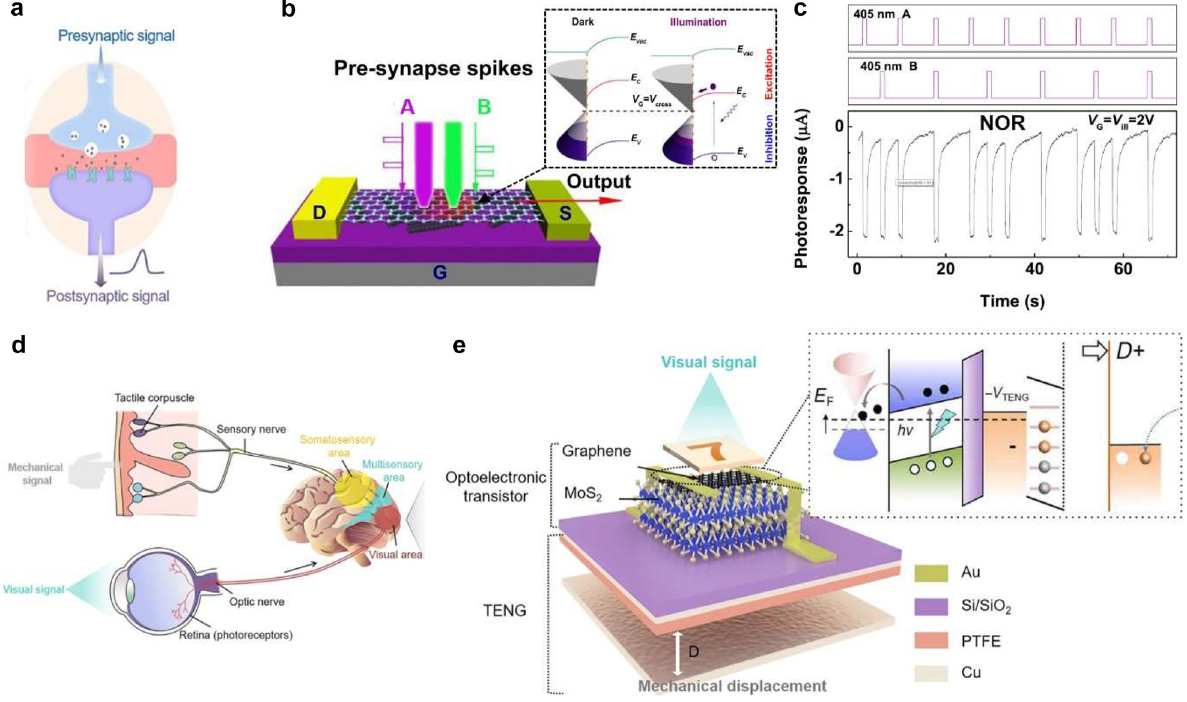
Figure 9: Data processing applications of graphene. (a) Schematic of biological synaptic transmission. (b) Artificial axon-multi-synaptic network based on graphene-SWCNTs hybrids under multiple light spikes. Inset image is the band diagram of graphene/SWCNTs interface before and after illumination. (c) The dynamic photoresponse of the NOR logic operation of the network. (d) Schematic illustrations of biological tactile/visual sensory systems. (e) Schematic structure of a graphene/ MoS 2 heterostructure-based arti fi cial synapse. The inset is the band diagram of the graphene/MoS 2 mechano-optoelectronic transistor at sepa- ration state. Panel (b) and (c) are adapted with permission from [152], Panel (a), (d) and (e) are adapted with permission from